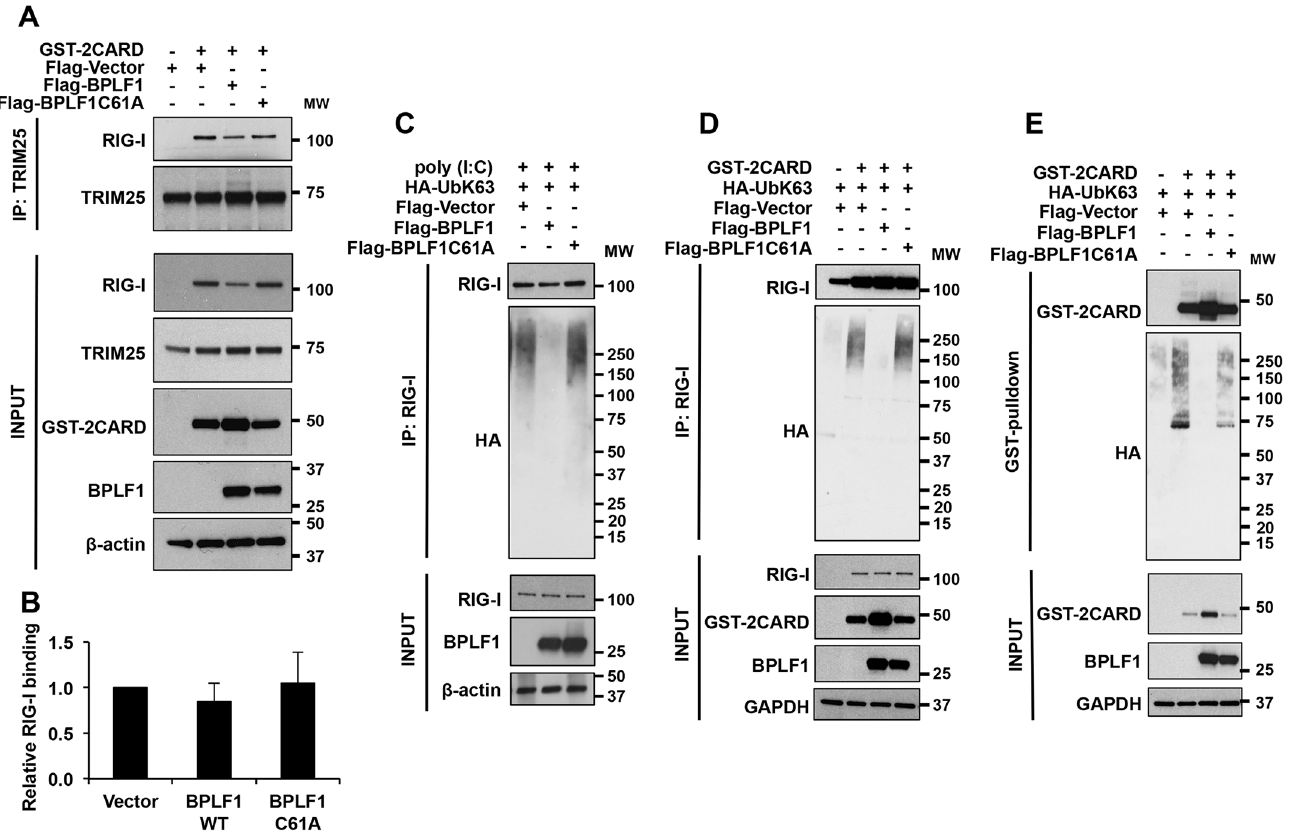
Fig 6. BPLF1 inhibits the ubiquitination of RIG-I. A . BPLF1 does not affect the interaction of TRIM25 with activated RIG-I. The IFN β signaling pathway was induced in HeLa cells transfected with the indicated FLAG-tagged plasmid by co-transfection of the GST-2CARD. Endogenous TRIM25 was immunoprecipitated and western blots were probed with a RIG-I specific antibody. One representative experiment out of 3 is shown. B . The intensity of interaction of the RIG-I band was quantified by densitometry. The ratio of the intensity of the immunoprecipitated RIG-I band relative to the input is shown. The means ± SD of 3 experiments are shown. C . BPLF1 inhibits the ubiquitination of RIG-I in cells treated with poly(I:C). HA-UbK63 was co-transfected in HeLa cells together with the indicated FLAG-tagged plasmid. RIG-I ubiquitination was induced by transfecting the cells with 2 μ g/ml poly(I:C) for 16 hrs. Endogenous RIG-I was immunoprecipitated and ubiquitination was detected by probing immunoblots with the anti-HA antibody. One representative experiment out of 2 is shown. D . BPLF1 inhibits the ubiquitination of endogenous RIG-I in cells expressing GST-2CARD. The experiment was performed as in Fig. 6C except that activation of the IFN β pathway was induced by transfection of GST-2CARD. One representative experiment out of 2 is shown. E . BPLF1 inhibits the ubiquitination of GST-2CARD. GST-pulldown was performed from lysates of cells treated as in Fig 6D and western blots were probed with the anti-HA antibody. One representative experiment out of 2 is